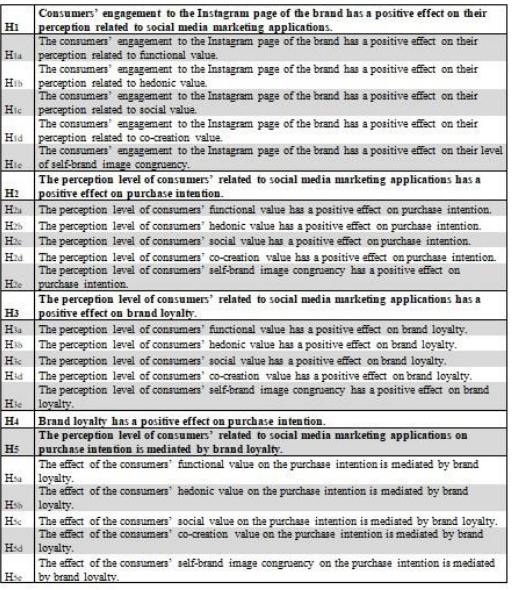
Table 1: Research